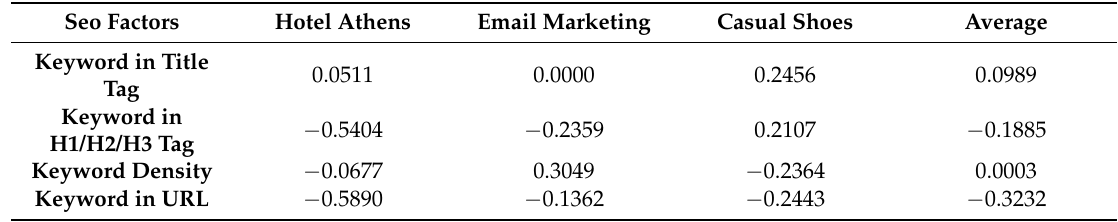
Table 2. Averages for each